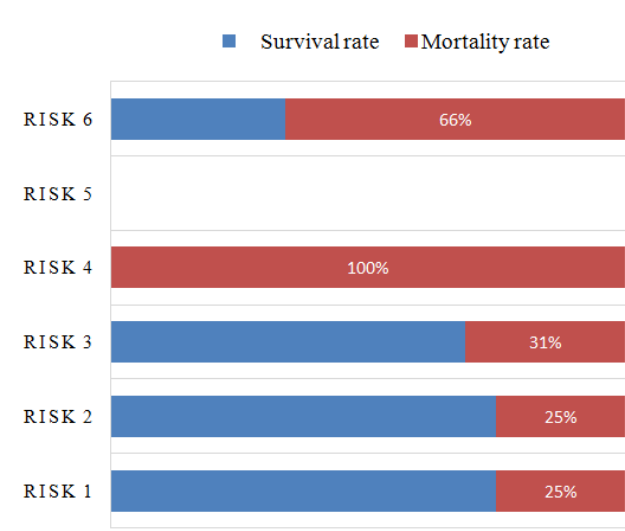
Fig. 1 – The frequency of surgical cases and mortality based on the study RACHS